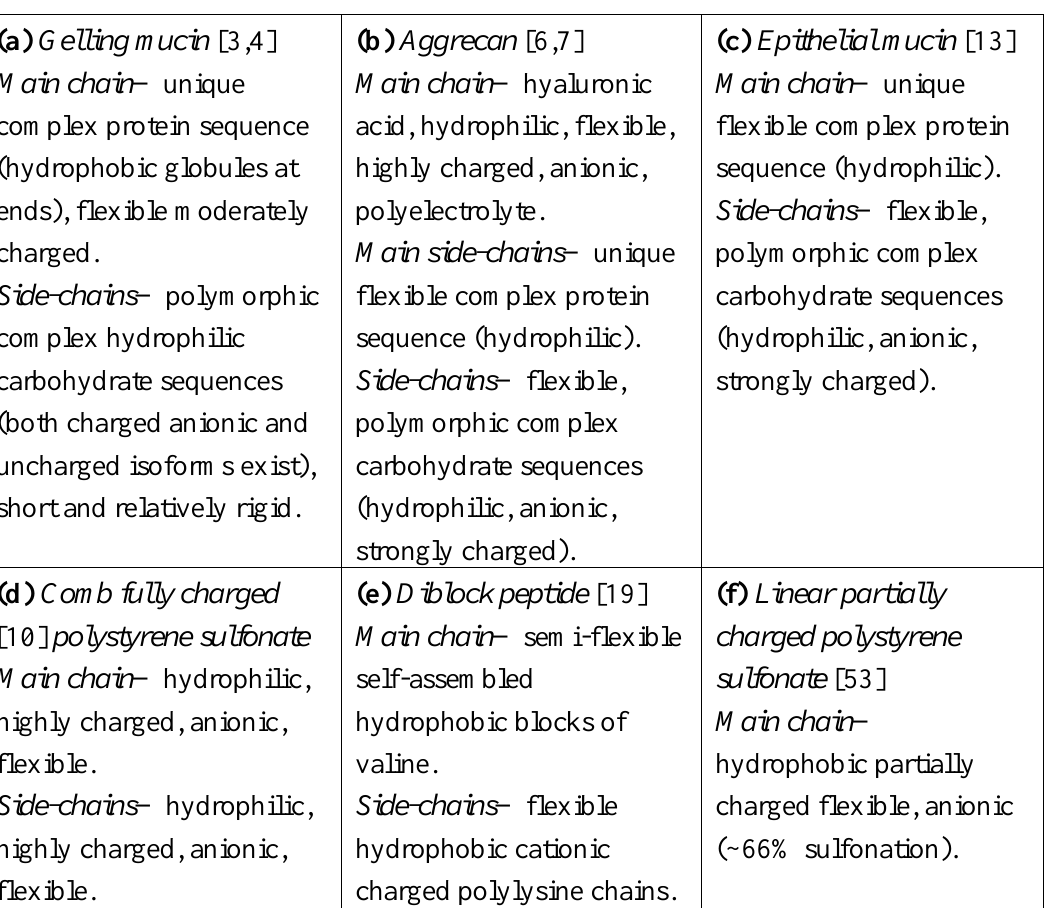
Table 1. Additional chemical details corresponding to the morphologies shown in Figure